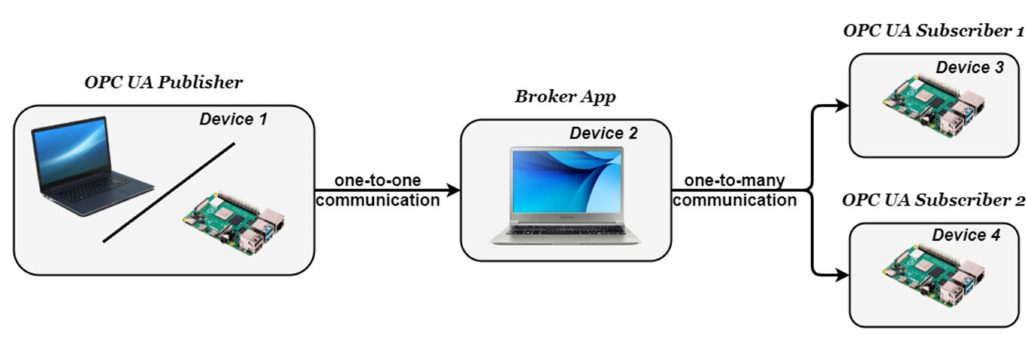
Figure 3. General Architecture of the Case